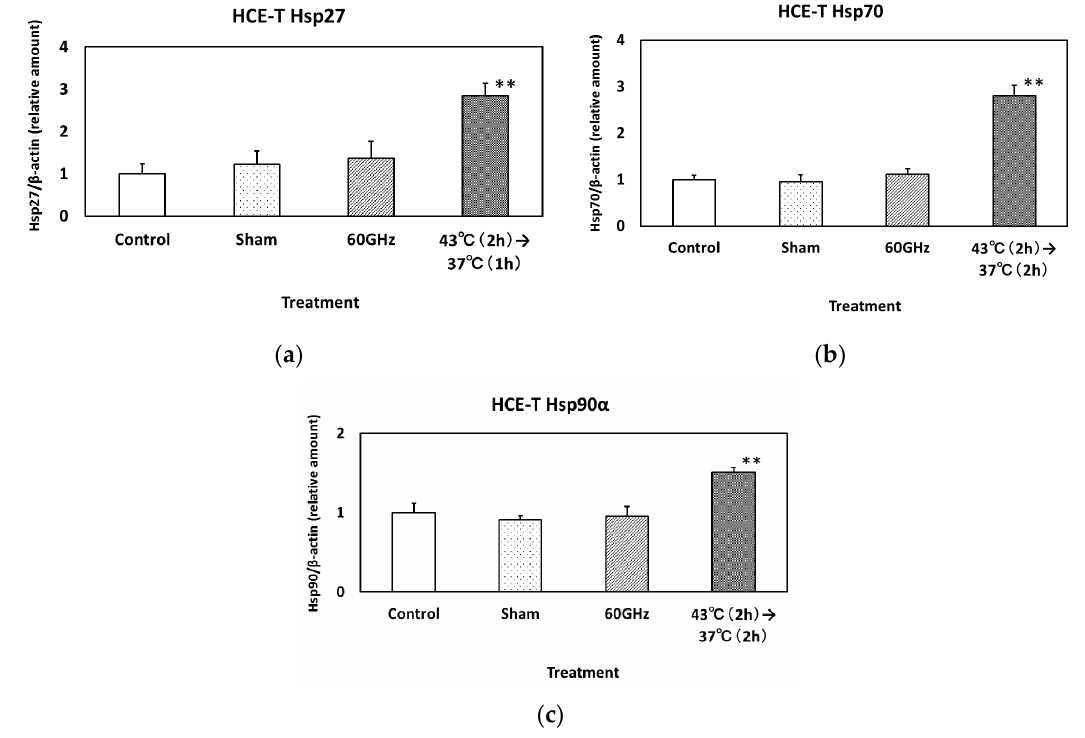
Figure 4. The expression of Hsp27 ( a ); Hsp70 ( b ) and Hsp90 α ( c ) in HCE-T cells exposed to 60 GHz radiation for 24 h. The positive control underwent heat treatment at 43 °C for 2 h. Data are presented as the mean ± SD from three independent experiments. Asterisks ** indicate p < 0.01.